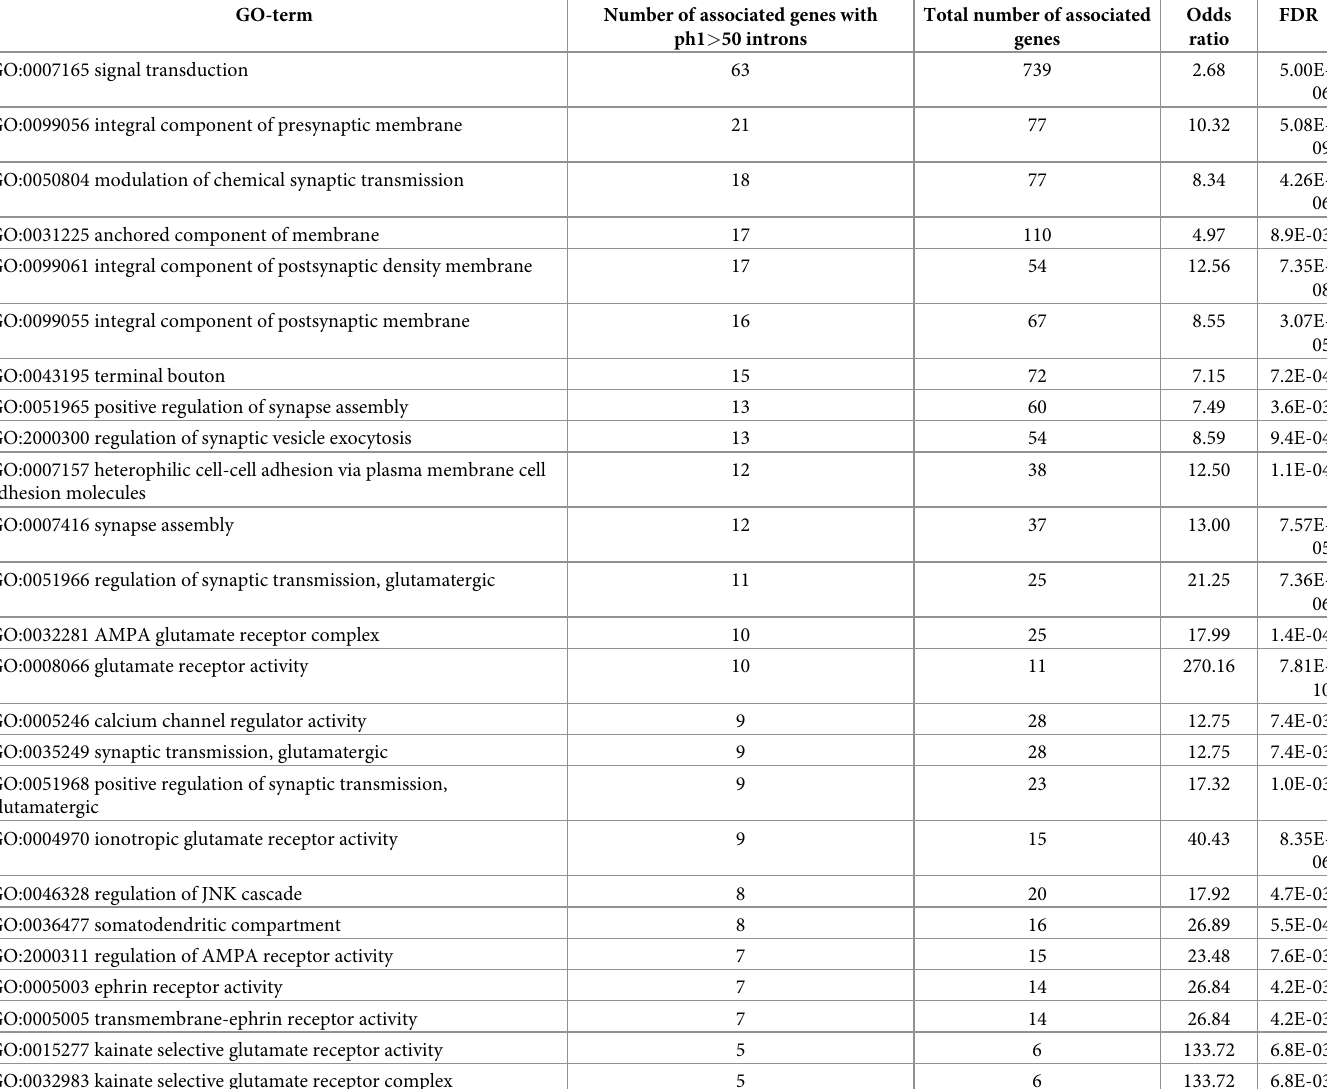
Table 1. 25 GO-terms significantly associated with genes of the ph1_ > 50 introns